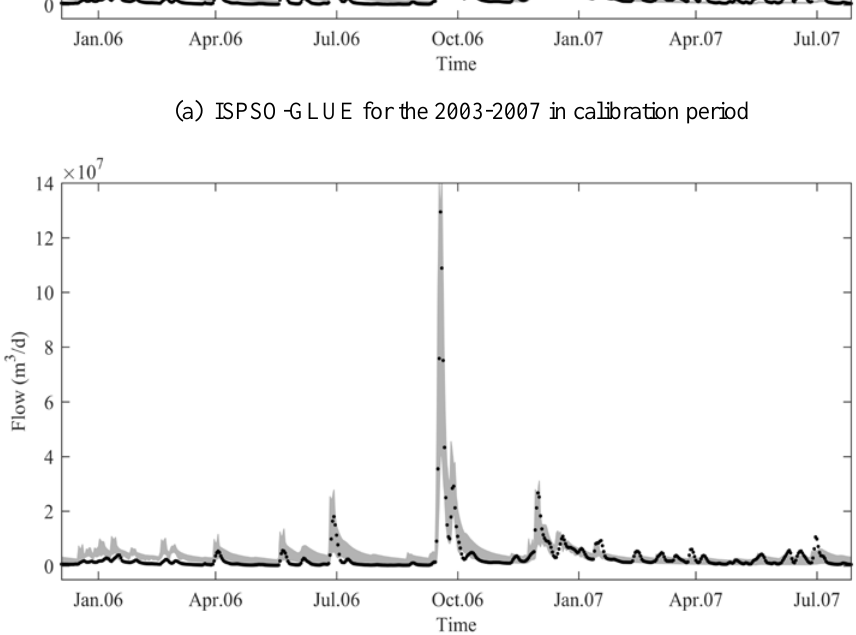
Figure 4. The 95% uncertainty bounds for the 2003–2007 calibration period from January 2006 to July 2007 (wettest period with the highest peak flow). The shaded area and dotted line represent the uncertainty bounds and observed flows, respectively.